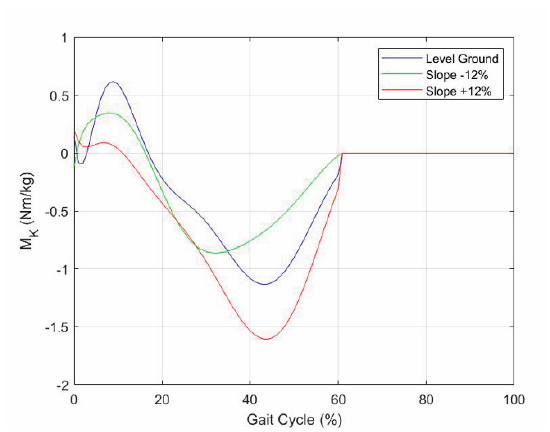
Figure 14 . Internal torque, M K , of the knee that the prosthesis actuation system must provide for